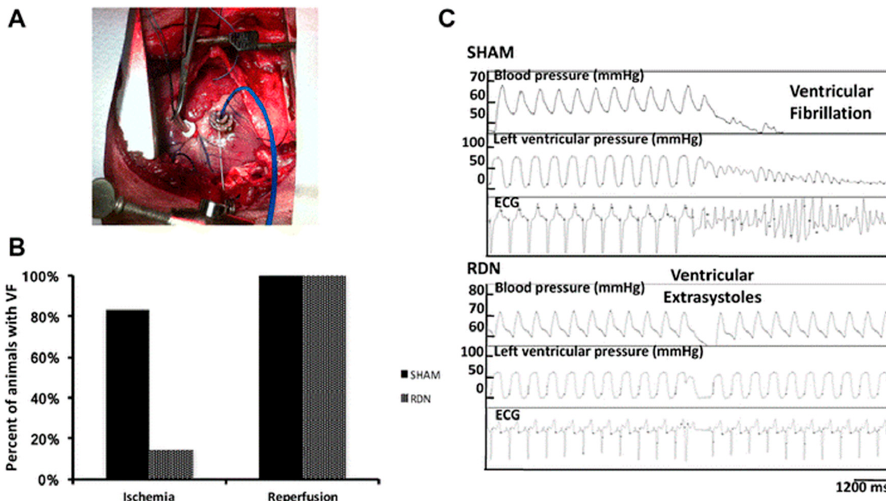
Figure 6. Effects of renal denervation on ventricular fibrillation in a pig model for ventricular ischemia and reperfusion. ( A ) Representative view of the left ventricular during ischemia reperfusion experiments. Atrial electrophysiology was recorded by an epicardial catheter. ( B ) Incidence of VF during ischemia and the reperfusion phase in RDN-treated compared to SHAM-treated pigs. ( C ) Representative hemodynamics and electrocardiographic (ECG) tracings during 20 min of left anterior descending coronary artery ligation followed by reperfusion in a SHAM-treated and a RDN-treated animal. RDN = renal denervation. VF = ventricular fibrillation